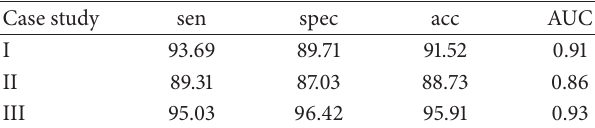
Table 7: Statistical performance evaluation of proposed framework for key player detection. Case